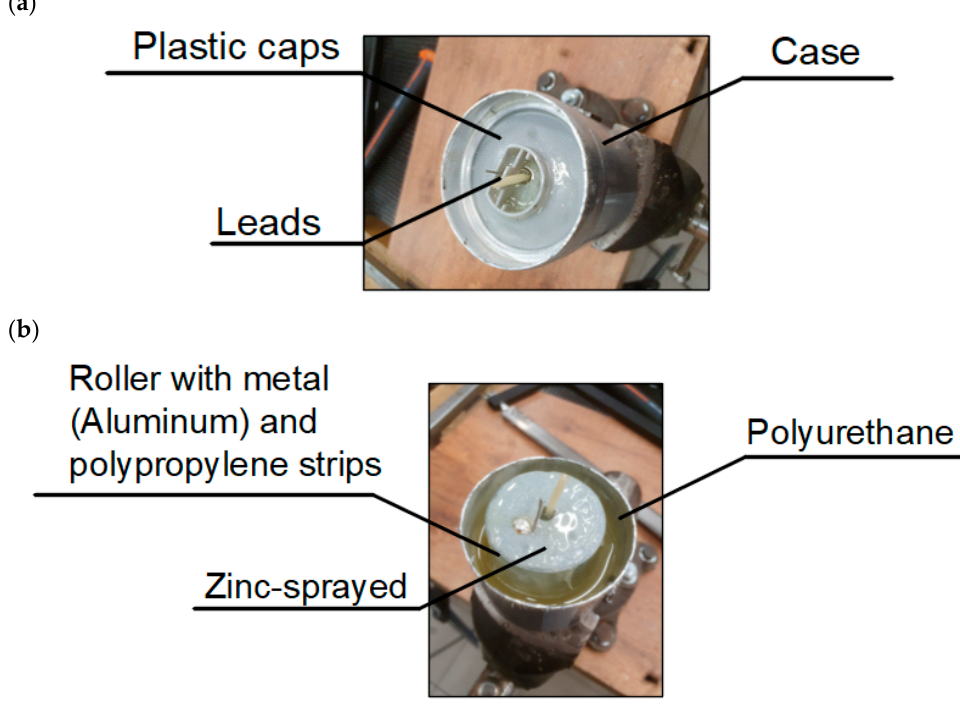
Figure 1. ( a ) The view after removing the outer case. One of the plastic caps is visible. ( b ) The view after removing the plastic cap.